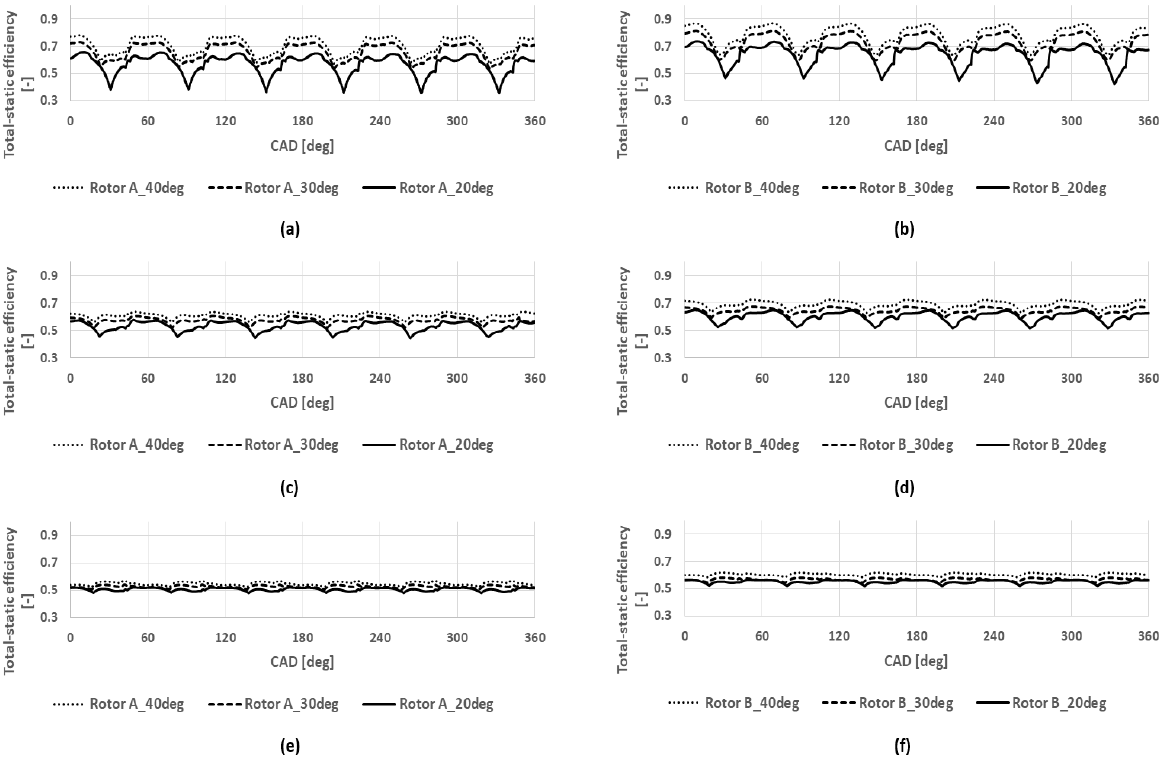
Figure 32. The total-static efficiency changes of the first-stage rotor for two rotor geometries at three different turbine speeds and VTG positions: ( a ) rotor A at 60,000 rpm, ( b ) rotor B at 60,000 rpm, ( c ) rotor A at 50,000 rpm, ( d ) rotor B at 50,000 rpm, ( e ) rotor A at 40,000 rpm, ( f ) rotor B at 40,000 rpm.